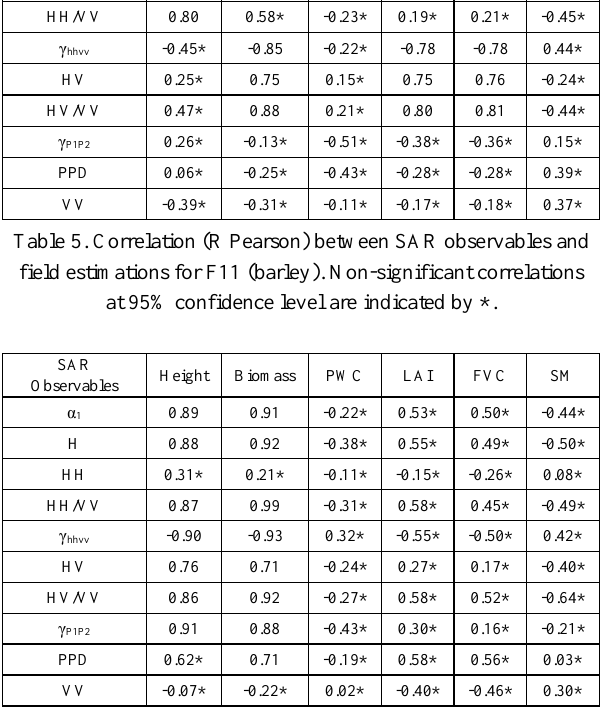
Table 6. Correlation (R Pearson) between SAR observables and field estimations for M9 (barley). Non-significant correlations at 95% confidence level are indicated by *.